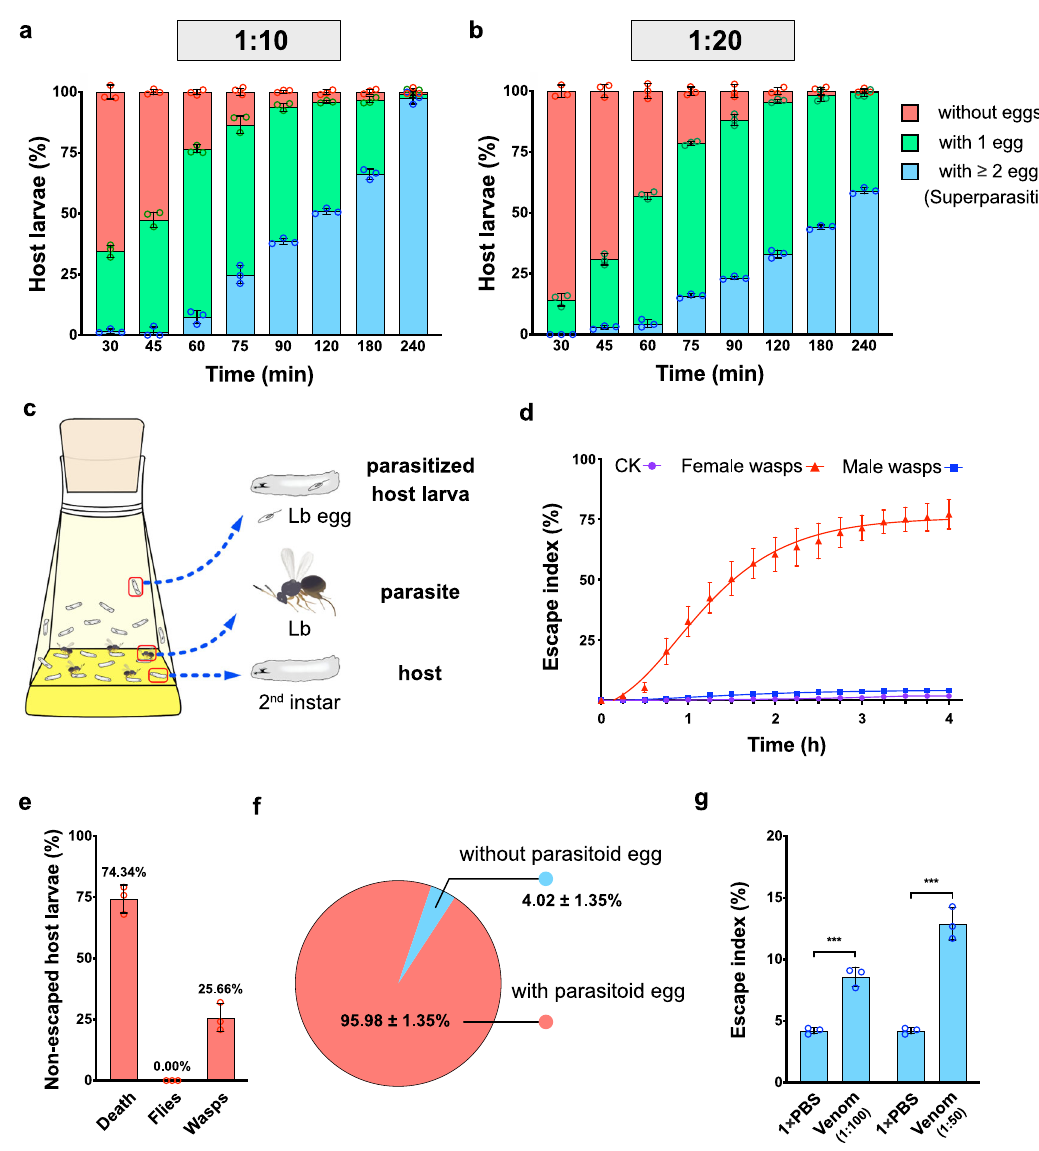
Fig. 1 Parasitoid venom is necessary for host escape behaviour. a Percentage of host larvae containing the indicated numbers of wasp eggs after exposure to female Lb at a parasite to host ratio of 1:10 in standard fl y food bottles for 30 min ( n = 245), 45 min ( n = 215), 60 min ( n = 285), 75 min ( n = 298), 90 min ( n = 256), 120 min ( n = 226), 180 min ( n = 157) or 240 min ( n = 209). Three biological replicates were performed. Data are presented as mean values ± SD. b Percentage of host larvae containing the indicated numbers of wasp eggs after exposure to female Lb at parasite to host ratios of 1:20 for 30 min ( n = 146), 45 min ( n = 209), 60 min ( n = 240), 75 min ( n = 201), 90 min ( n = 194), 120 min ( n = 166), 180 min ( n = 156) or 240 min ( n = 178). Three biological replicates were performed. Data are presented as mean values± SD. c Schematic of the experiment in which wild-type Drosophila 2nd instar (host) larvae in fl y bottles were exposed to Lb female wasps. The images were crafted using Af fi nity Designer v1.8.6 and Procreate v4.2.2. d The escape indices (number of hosts exhibiting short-term escape behaviour divided by the total number of hosts multiplied by 100) of hosts exposed to no wasp control (CK, purple curve, n = 380), to female wasps for 4 h (female wasps, red curve, n = 358) and to male wasps (male wasps, blue curve, n = 461). The number of escaped hosts was recorded and summed every 15 min. Three biological replicates were performed. The difference in escape index between treatments was determined by one-way ANOVA along with Fisher ’ s least signi fi cant difference test (see statistics of each time point in Supplementary Table 4). e The percentage of remaining host larvae that died, emerged as fl ies and hatched wasps after exposure to wasps for 4 h. Data are presented as mean values ± SD. f The percentage of host larvae exhibiting escape behaviour that contain Lb eggs in behaviour assays. g Escape indices for Drosophila hosts treated with venom at 1:100 and 1:50 dilutions, with 1× PBS as controls. Left to right: n = 240, 296, 240 and 263. At least three biological replicates were performed. Data are presented as mean values ± SD. Signi fi cance was determined by two-sided unpaired Student ’ s t test (1:100 venom: P = 0.0008; 1:50 venom: P = 0.0004; *** P < 0.001). Source data are provided as a Source data fi